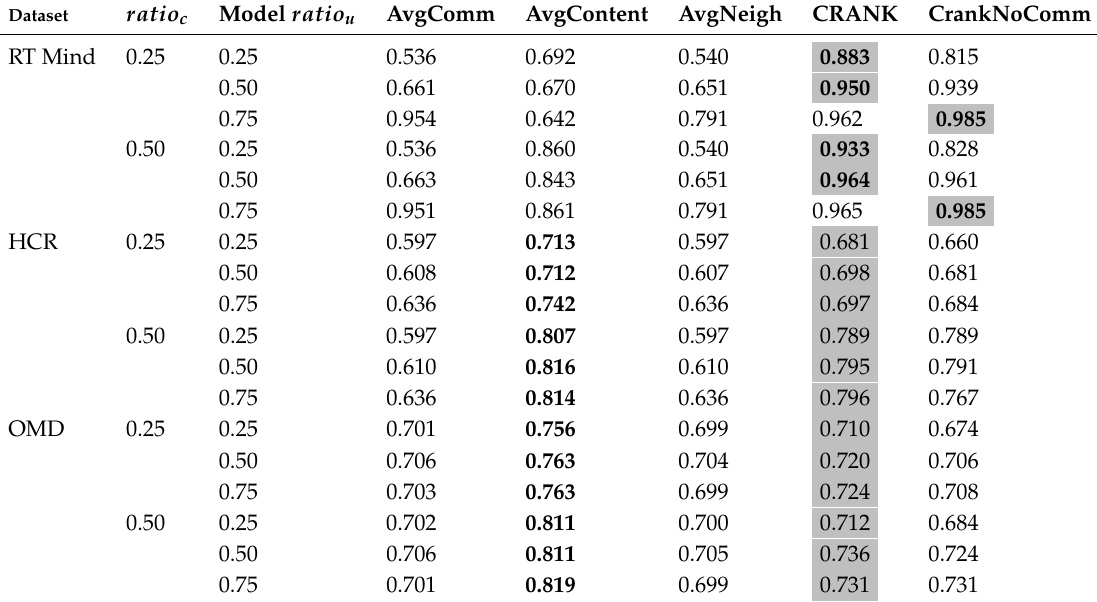
Table 3. User-level classification accuracy for each